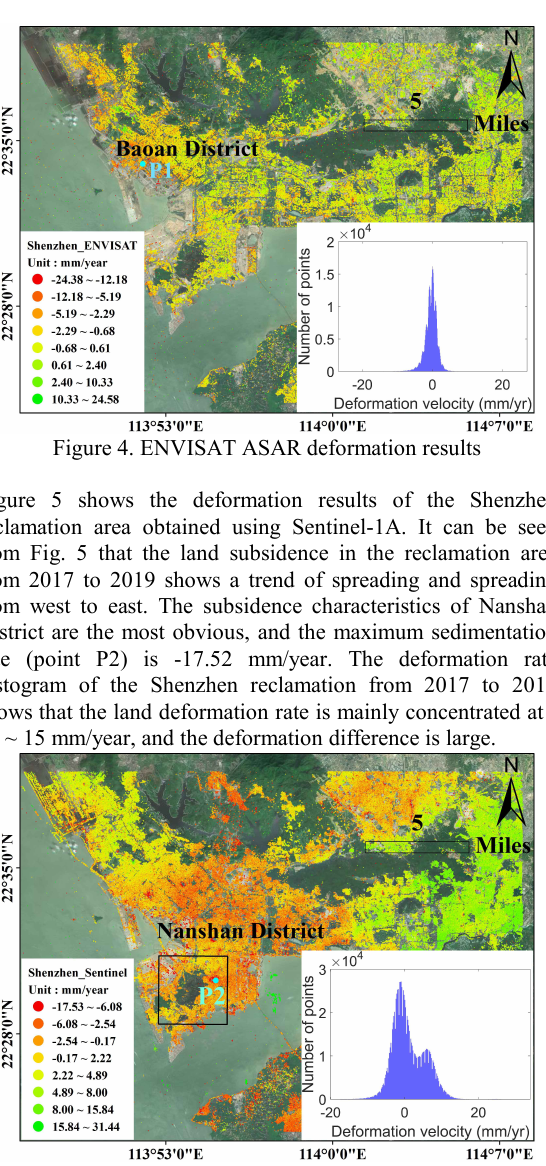
Figure 5. Sentinel-1A deformation